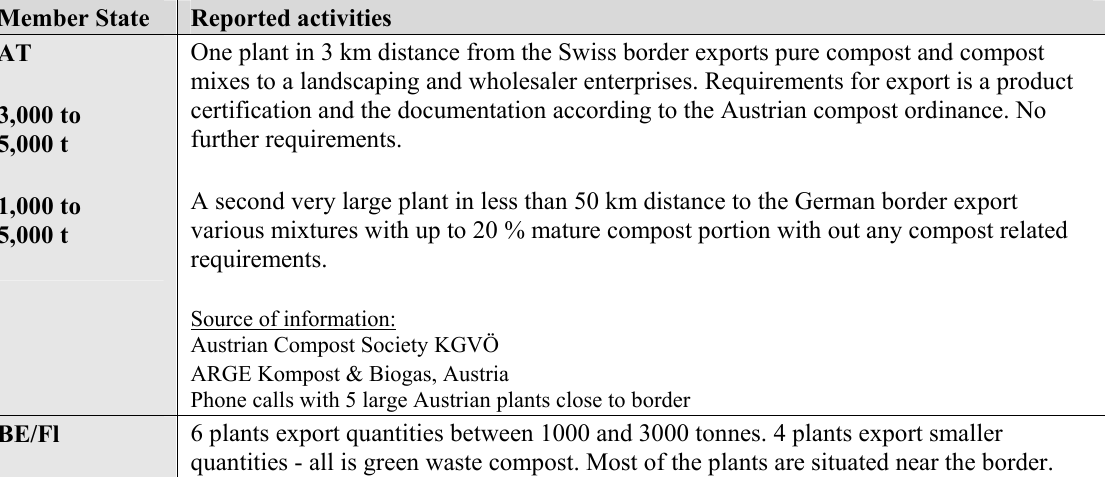
Table 51: Report from the Countries about ex- and import activities and